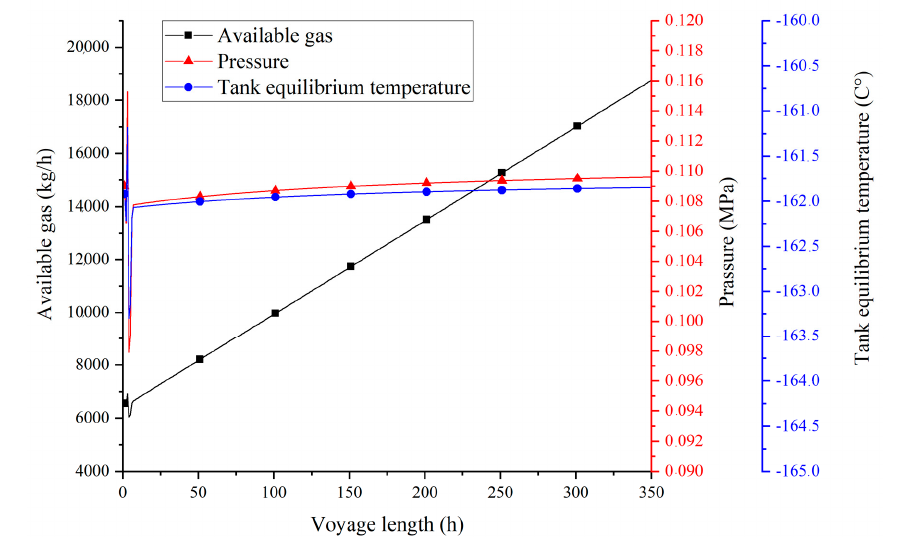
Figure 11. Cargo equilibrium temperature maintenance for the voyage. 357